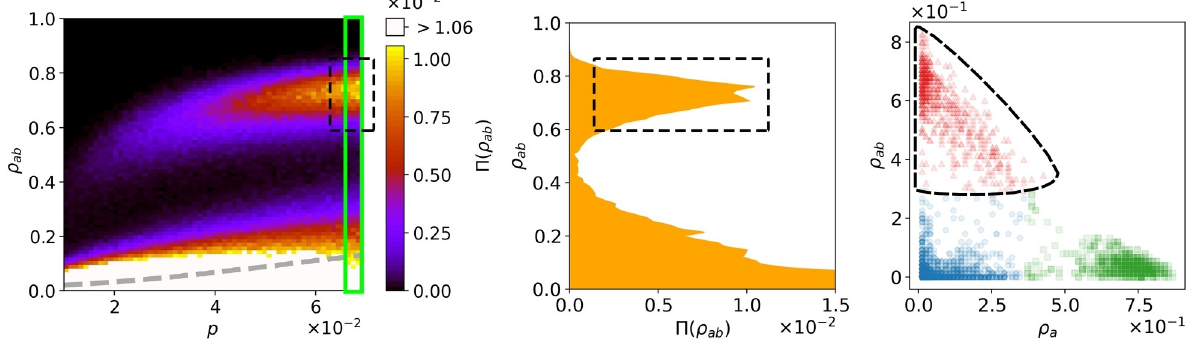
Fig 4. Systematic measurement of P (Eq 1) and ab (Eq 2). The figure demonstrates how the k-means clustering measure works. As an example, we ab see the coinfection simulation on the DCWB shuffled hospital network with q = 1 and r = 0.001. The left panel shows the density of the ab population, and the probability that a realization settles on the given value of the density ( π ( ρ ): color axis) while varying p, which is the first infection probability. ab The gray dashed curve demonstrates the average ρ ab . The middle panel distinguishes precisely the two epidemic branches in the left panel at p = 0.069, the vertical window. The right panel shows the fraction of individuals recovered from one disease (x axis) and from both diseases (y axis), within each realization. Each marker denotes a single realization and different colors and shapes indicate different clusters: red triangles (double infection outbreaks), green squares (single infection), blue pentagons (no outbreaks). The dashed shapes, encircle the realizations which make up the outbreak branch (OB) in each illustration. 50000 realizations have been simulated, but for illustrative purposes, only a sample of 5000 realizations are depicted in the right panel.